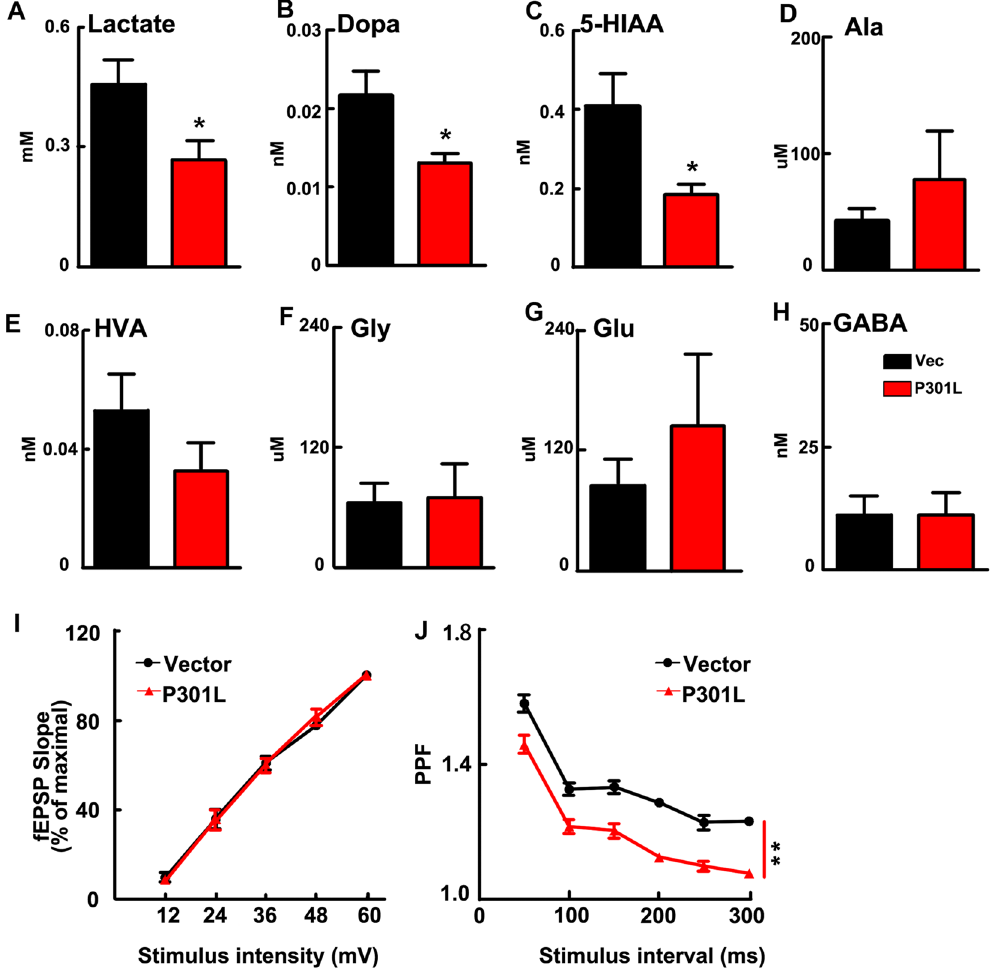
Figure 5. P301L hTau transduction in MEC decreases the probability of presynaptic transmitter release. ( A ) Microdialysis results indicated the lactate level was significantly reduced. ( B , C ) The levels of dopamine and 5-HIAA (monoamine neurotransmitter or the metabolites) were also decreased in the intercellular space, while the levels of Ala, Hva, Gly, Glu and GABA were not changed ( D – H ). (n = 6 per group, * p < 0.05). ( I ) Input- output curve of the EC-DG perforant path fibers. ( J ) Mutant P301L hTau produced a decrease of PPF in PP-DG pathway (n = 3 per group, 9 slices, ** p < 0.01). Data were expressed as mean ±